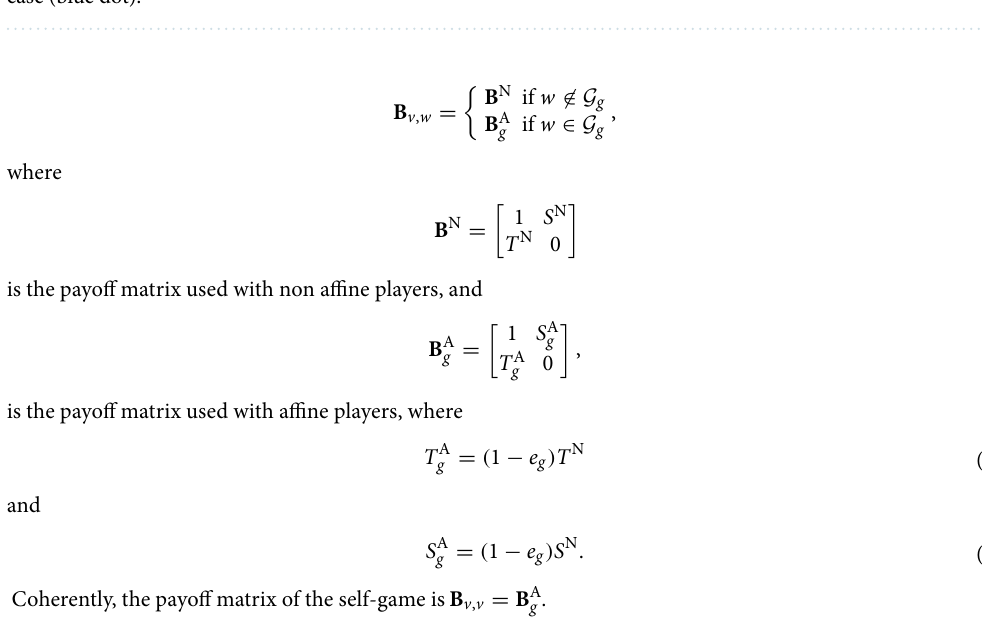
Figure 1. Pictorial representation of the function β v reported in (4) (blue) in comparison with a linear scaling ′ c g > 0 in the linear case (red dot), and for c g > 0.4 in the quadratic (red). β v exceeds the critical value ρ N k g for case (blue